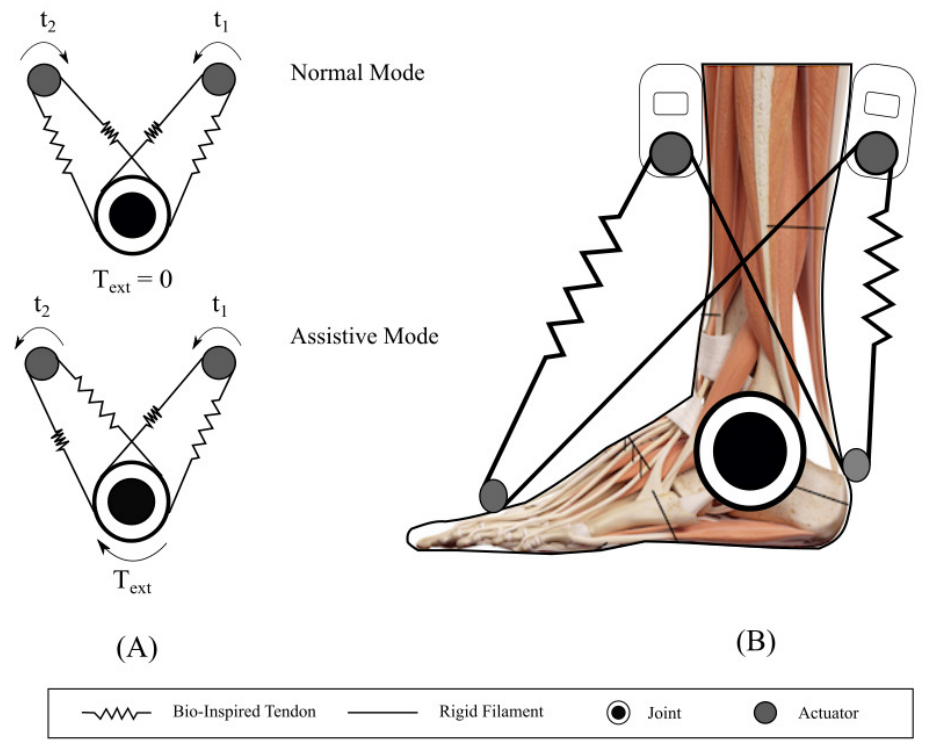
Figure 3. Soft actuation principle for robotic orthosis T-Flex. ( A ) Two operation modes: Normal mode is present when both motors act in opposite directions, generating a null external torque. In this state, there is a constant stiffness on the joint. Assistive mode operates when both motors are actuated in the same direction, generating an external torque. In this state, the actuation system supports the rotation of the joint in any direction. ( B ) Actuation-system configuration for the T-Flex orthosis: Both motors are attached in series to elastic elastic tendons that transmit the axial force to the joint. Depending on operation mode, this configuration allows to stabilize the ankle joint or to support and assist the rotation movement of the